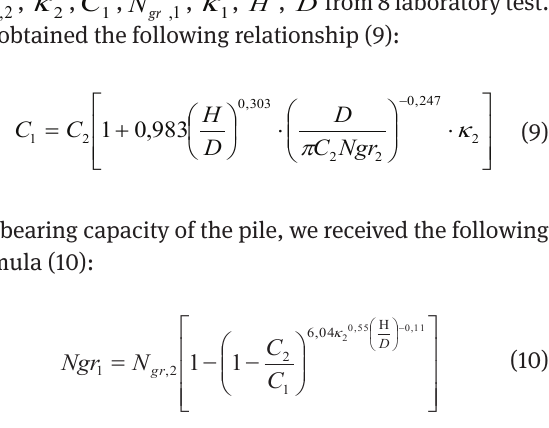
Table 2. Comparison of the M-K approximation of piles 1 and 8 in experiments.